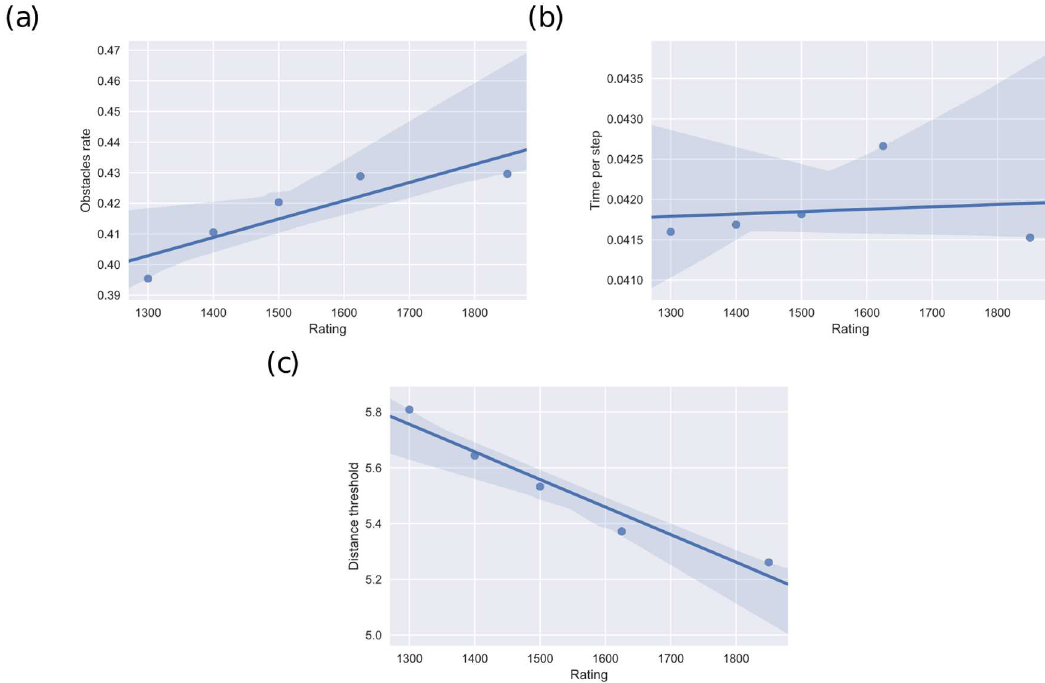
Fig 3. Specificity. Correlation between parameters of the model and player ratings. a) Density of obstacles (a proxy for the complexity of the space of solutions explored), b) time per iteration and c) distance to threshold as a function of time in the game. Correlations show significant p-values for density of obstacles ( p < 0.006) and distances ( p < 0.04). Strongest players (first quintile) explore a more complex decision space (more obstacles, KS Test p < 10 −17 )) compared to weakest players (fifth quintile), with similar time per step (KS Test, p = 0.20), leading to shorter distances (KS Test, p < 10 −7 ).